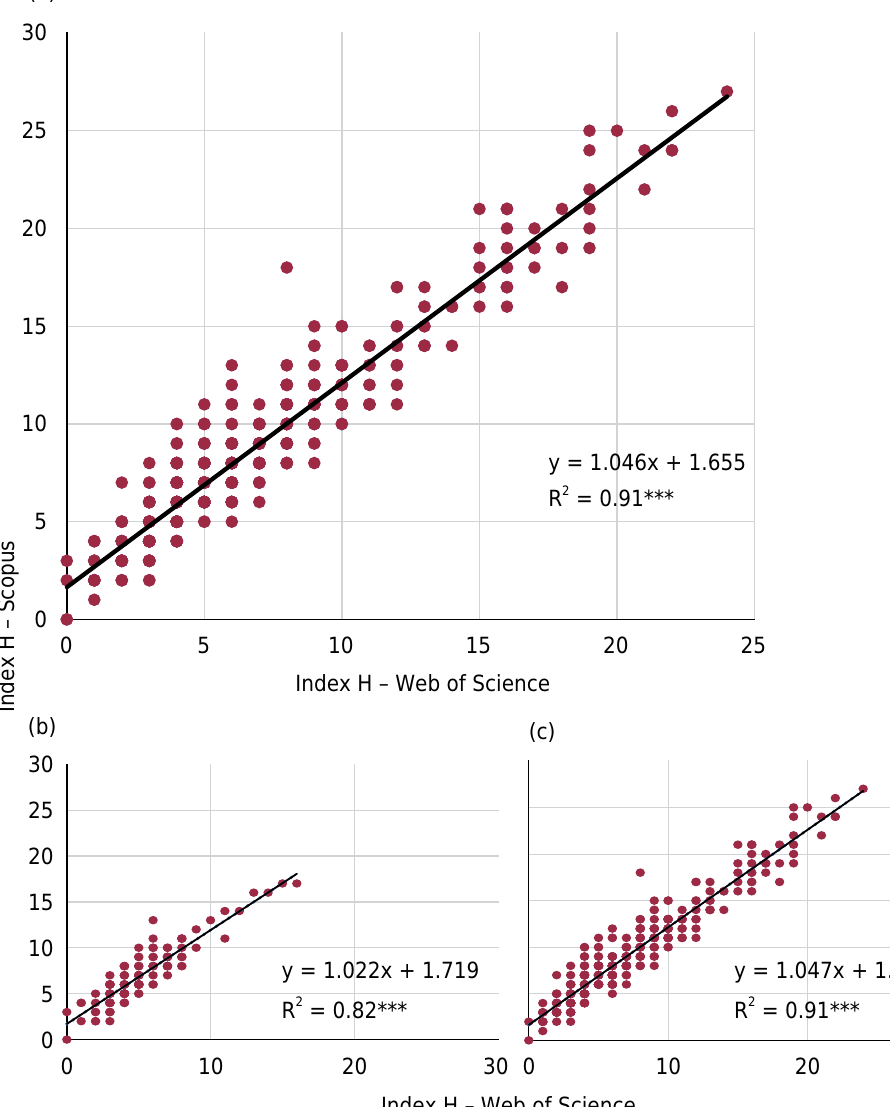
Figure 4. Relationship between H indices from Scopus (H-Sco) and Web of Science (H-WoS), for researchers in Agronomy, for all researchers regardless of sex (a) and by gender women (b) and men (c), in CNPq Call